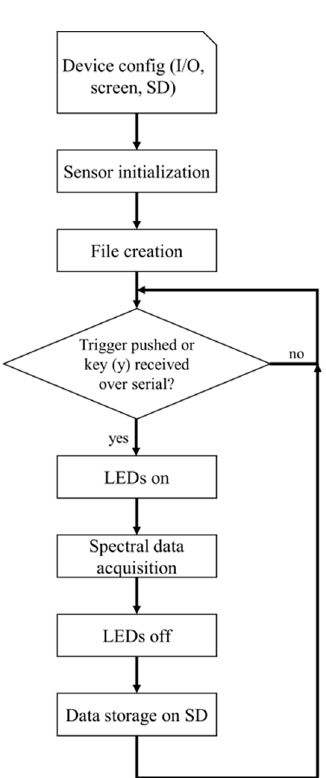
Figure 4. Flow chart of the process for multispectral data capture.